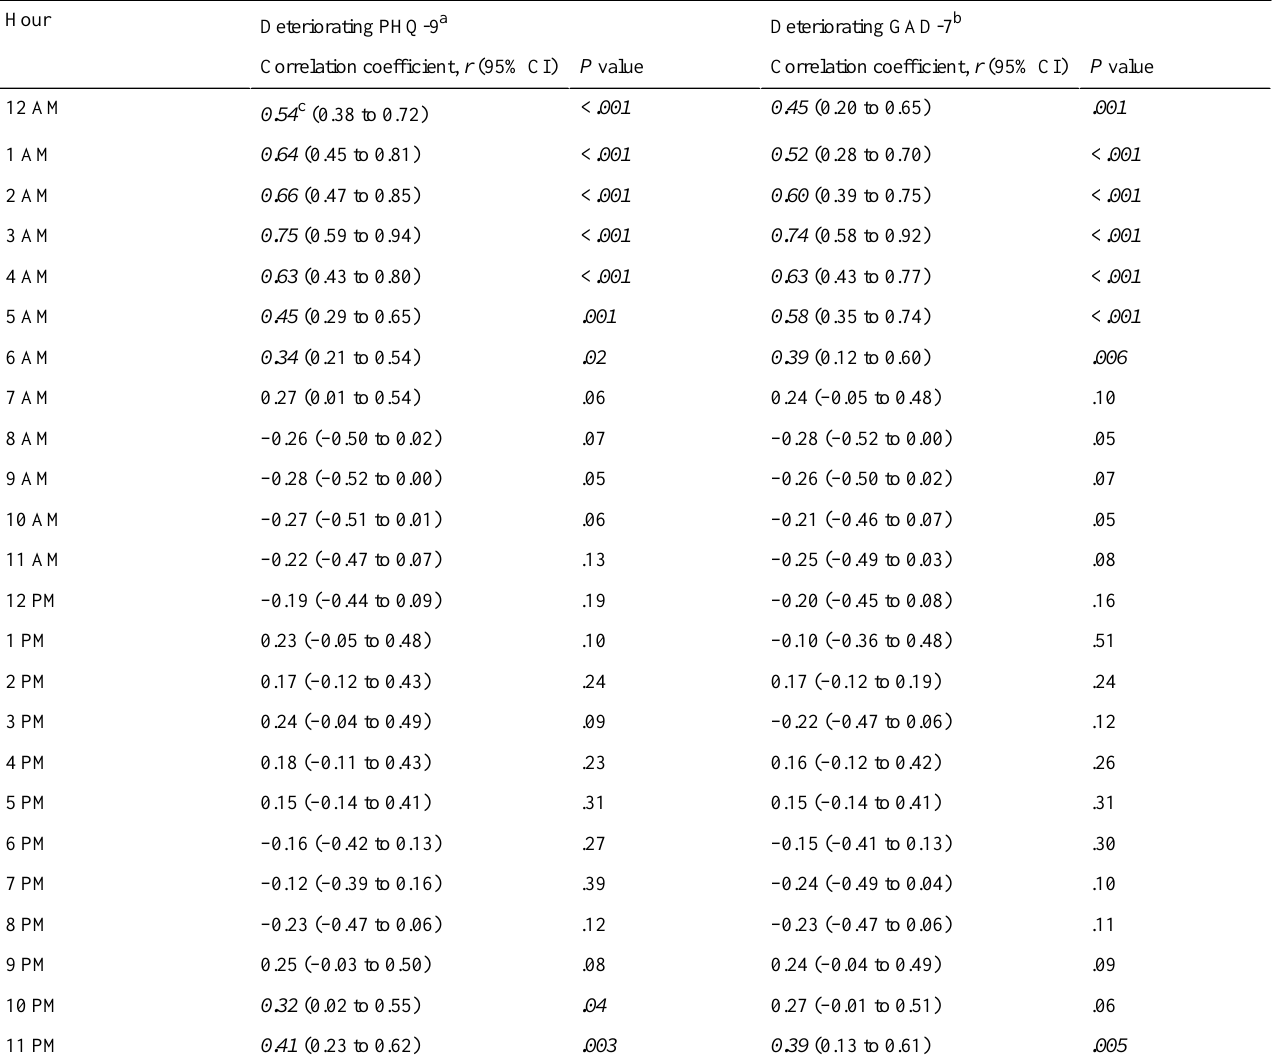
Table 2. The correlation coefficients between the change in the volume of online activities of each hour in a day and deteriorating PHQ-9 and GAD-7